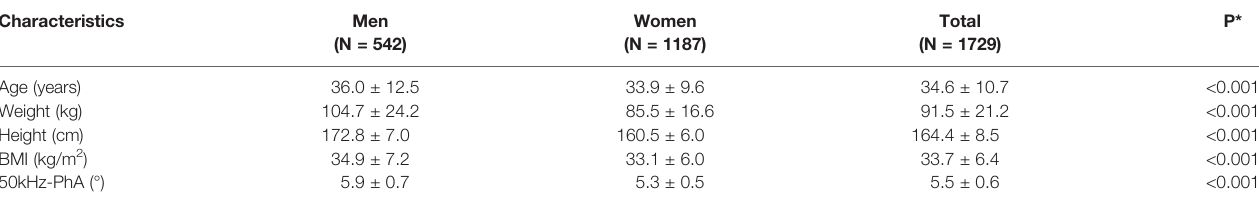
TABLE 1 | Age, weight, height, BMI, and 50kHz-phase angle of the participants by sex.